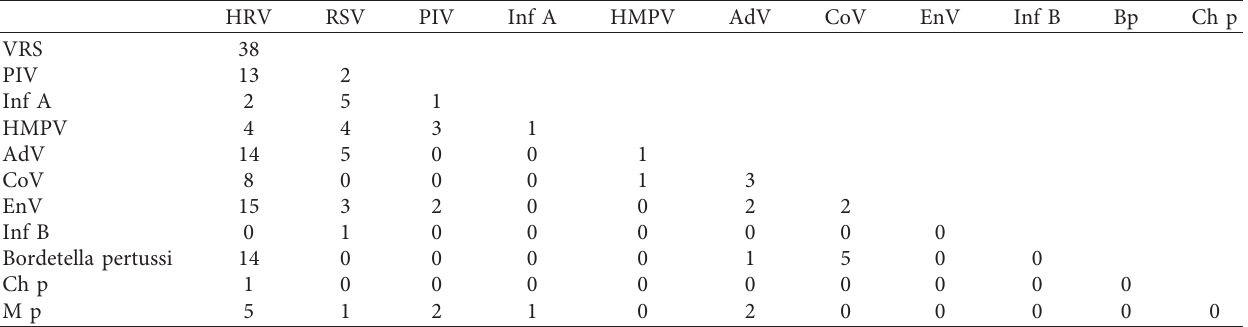
Table 4: Prevalence of co-infection of respiratory pathogens in children.